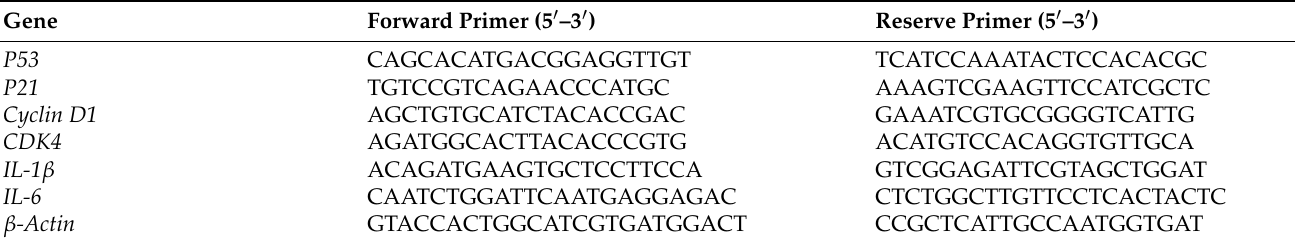
Table 1. The primer sequences used for the